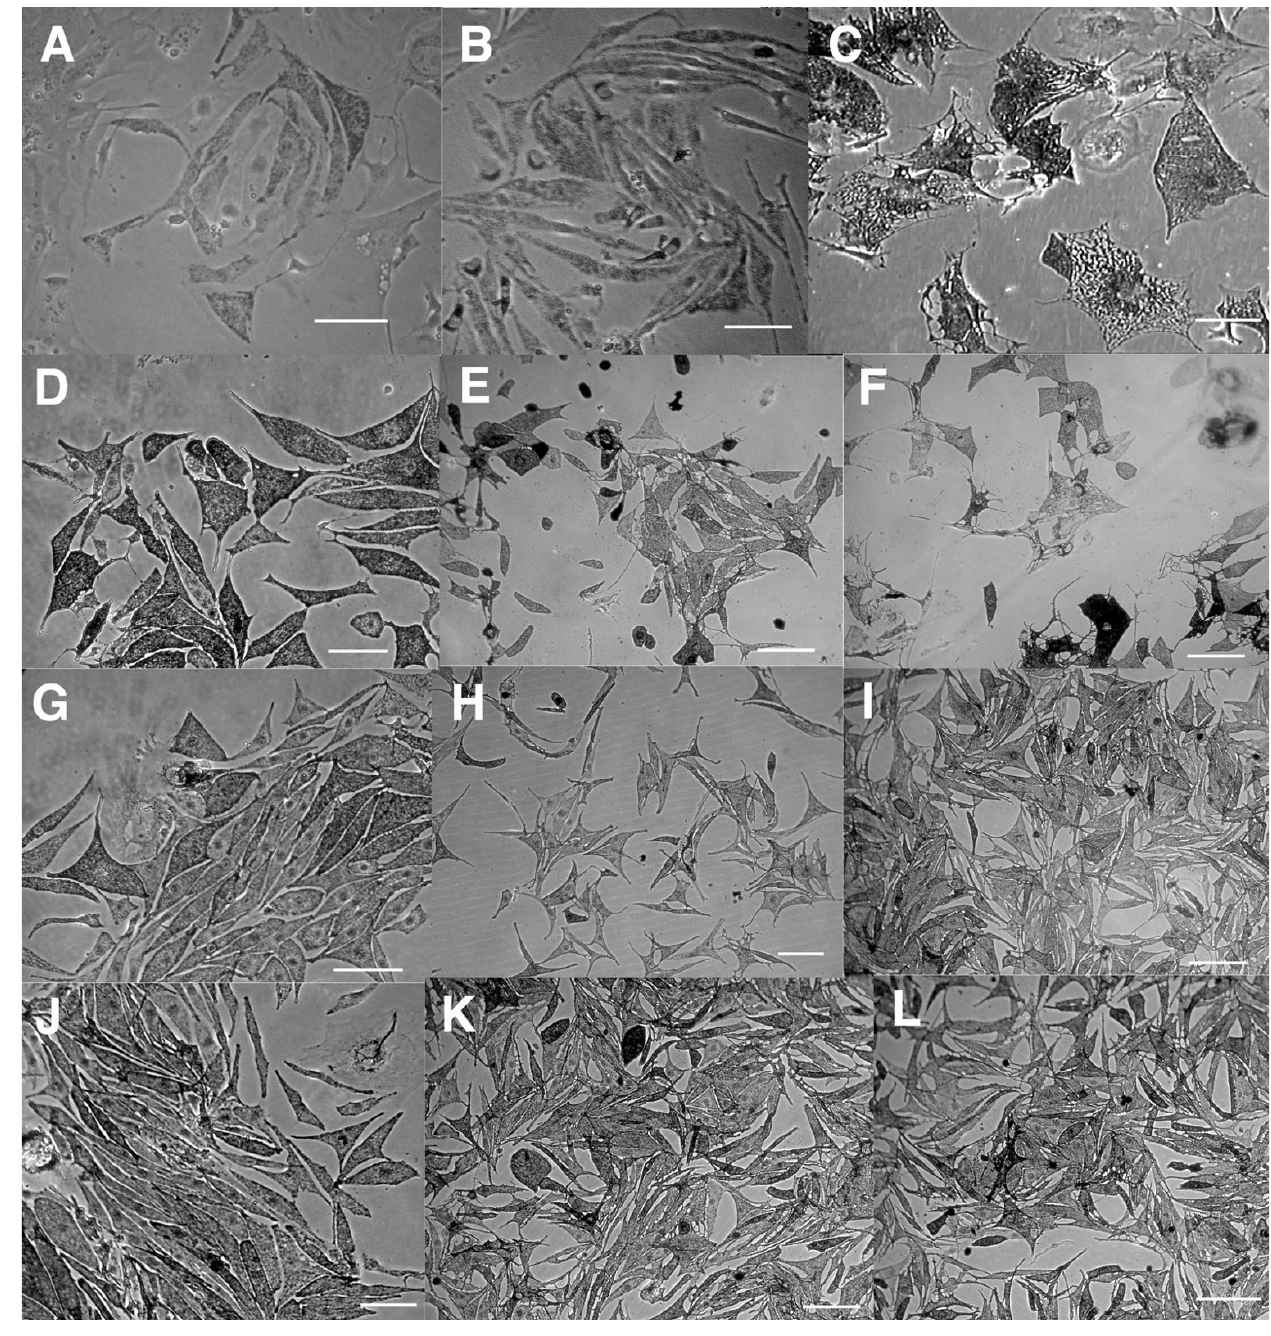
Figure 2 The absence of at least one Ink4a-Arf allele overcomes the senescence of primary melanocytes in culture . Melanocytes from heterozygous YAC Tyr transgenic in homozygous Tyr c -32 DSD background became large, flat, vacuolated and highly pigmented (A, B). No surviving melanocytes were detected in the culture dishes after the senescence step (C). Melano- cytes from Ink4a-Arf +/- (G, H, I) and Ink4a-Arf -/- (J, K, L) mutant mice in a Tyrp1 B background are black, small, bipolar, pale and without significant sings of senescence, as compared to wild type Ink4a-Arf +/+ melanocytes (D, E, F). A: culture at day 10; B: cul- ture at day 18; C: culture at day 48; D, G, J: cultures at day 43; E, H, K: cultures at day 57; and, F, I, L: cultures at day 82. Scale ebars in C, D, G, J = 200 µ m and in A, B, E, F, H, I, K, L = 150 µ